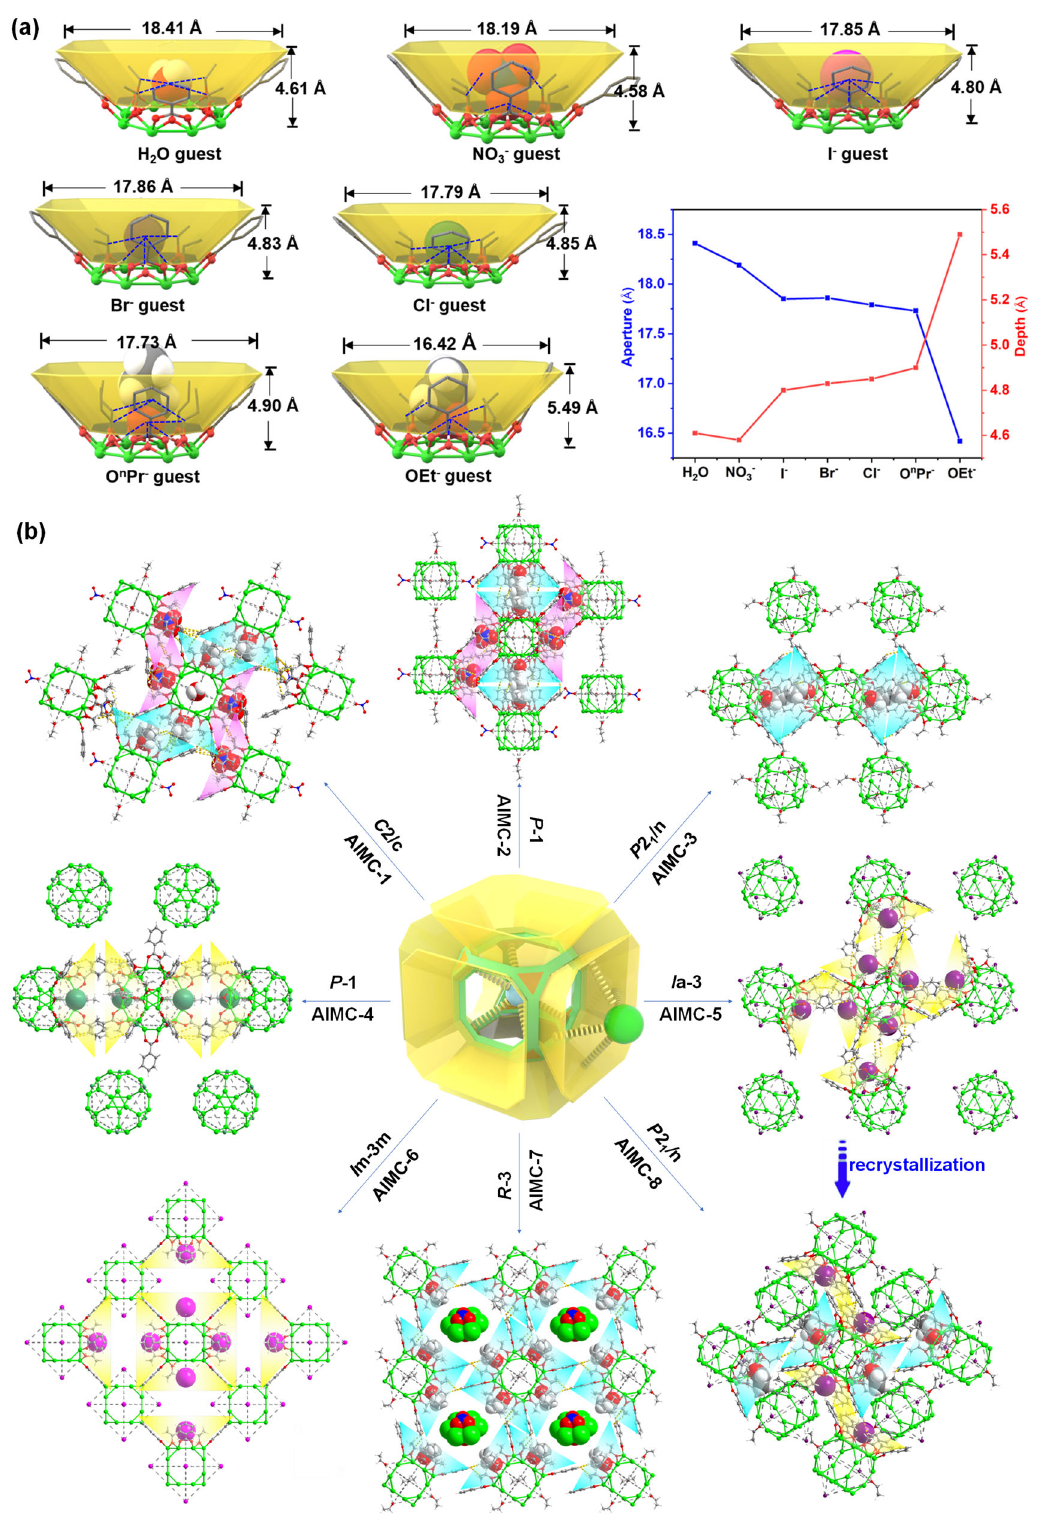
Fig. 3 | Supramolecular lattice assembliesbetweenthe cationicAl 24 host and a varietyofguests.a TheAl 8 macrocyclicsubunitsadapttotheaccommodatedH 2 O (in AlMC-1 ),NO 3 − (in AlMC-1 ),I − (in AlMC-6 ),Br − (in AlMC-5 ),Cl − (in AlMC-4 ),O n Pr − (in AlMC-2 ) and OEt − (in AlMC-3 ) guests. The blue dotted lines indicate that there are strong hydrogen bond interactions between two atoms (the details of the hydrogenbondinteractionsareprovidedinSupplementaryFigs.20 – 25). b Packing diagrams of AlMC-1 – AlMC-8 . Hydrogen-bond interactions between neighboring